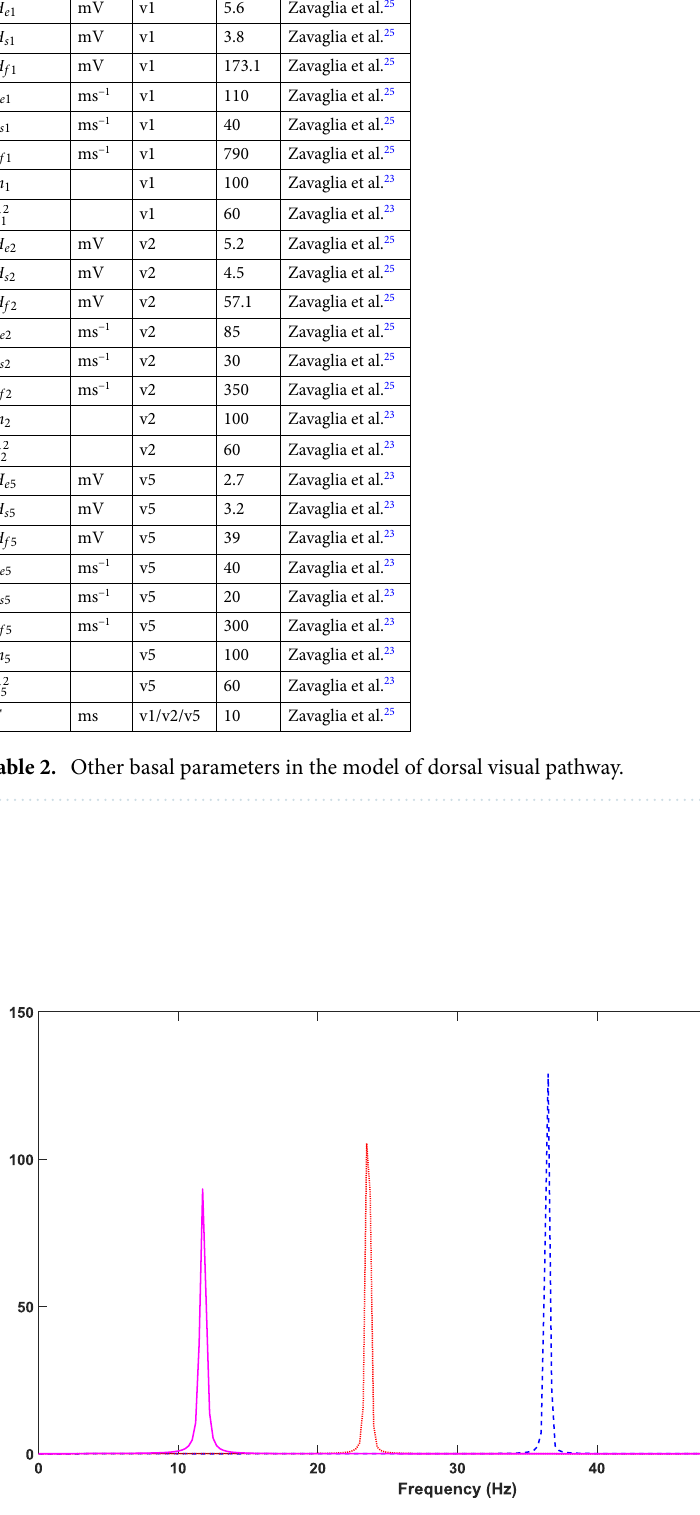
Figure 2. PSD of areas v1 (blue dotted line), v2 (red dashed line) and v5 (pink solid line) without long synaptic projections between the three cortical